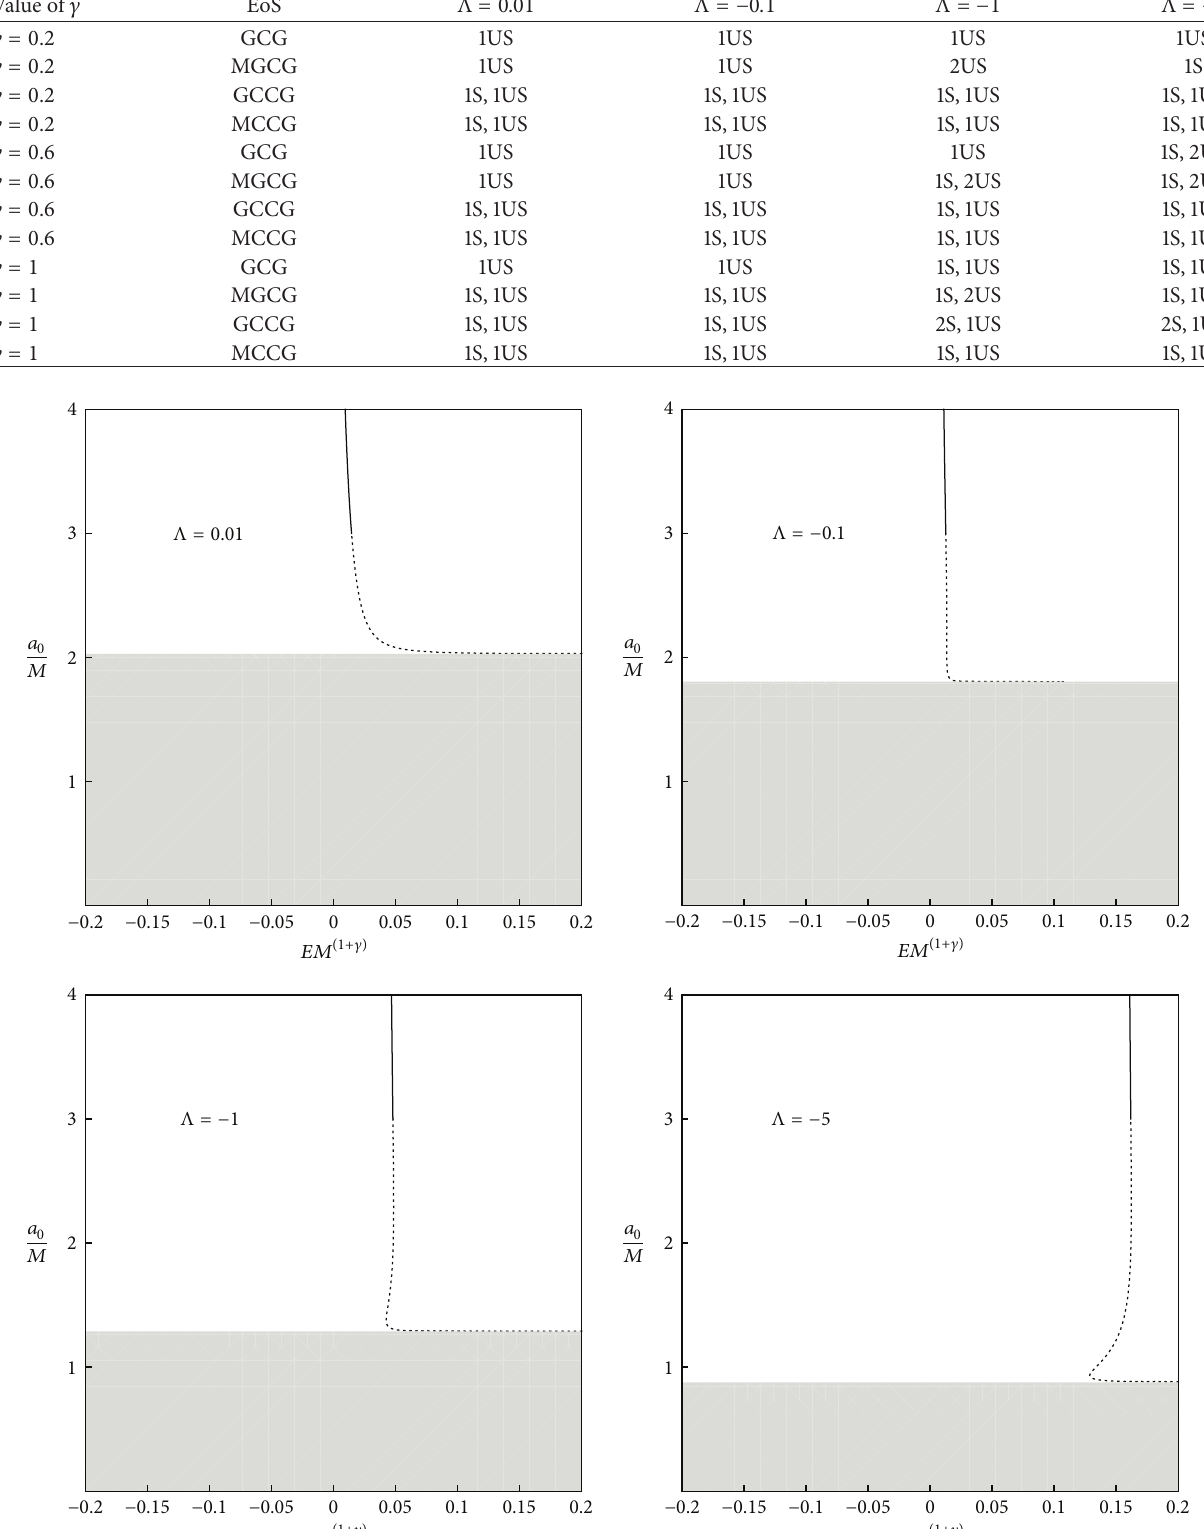
Table 1: Comparison of solutions for different EoS.